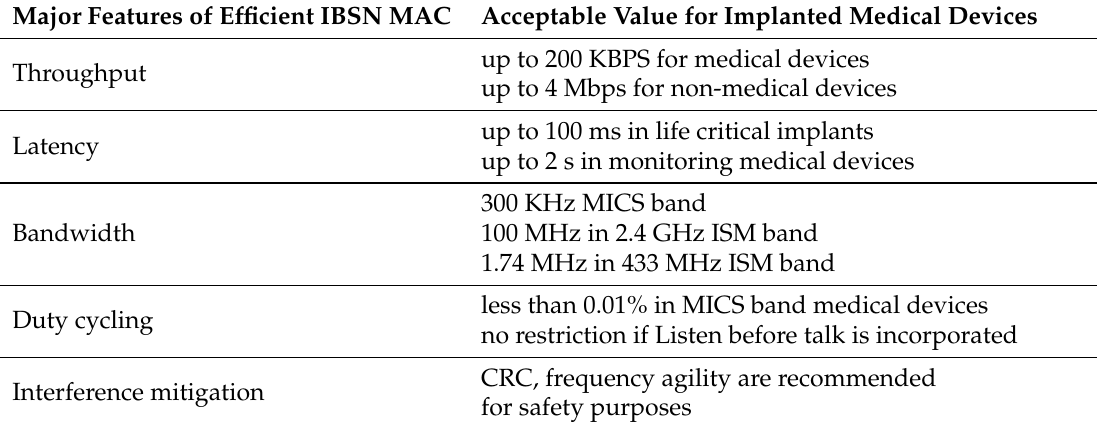
Table 5. Features of MAC protocols as suggested by IEEE